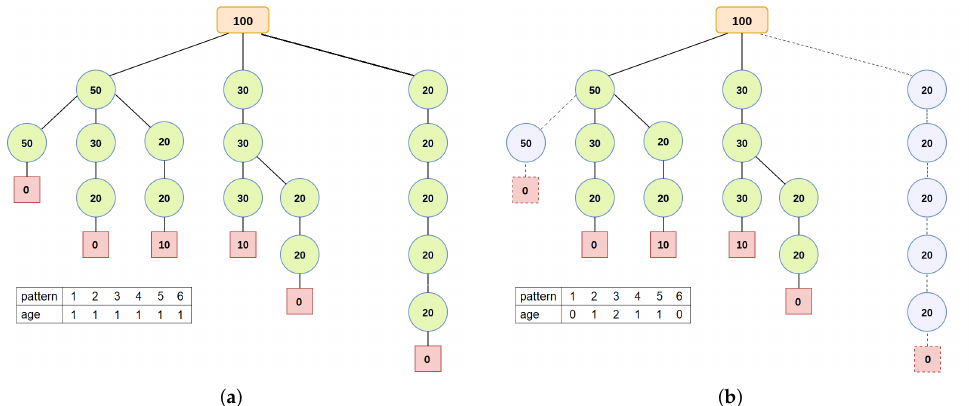
Figure 4. In the representation of reduced instances of the problem, each position in the array is associated with a cutting pattern in the search tree. The cutting patterns considered in the reduced instance present a value greater than or equal to 1 (one) in the array and are highlighted in green in the search tree. In ( a ), we illustrate a reduced instance with all cutting patterns from the search tree and, in ( b ), a reduced instance with only 4 cutting